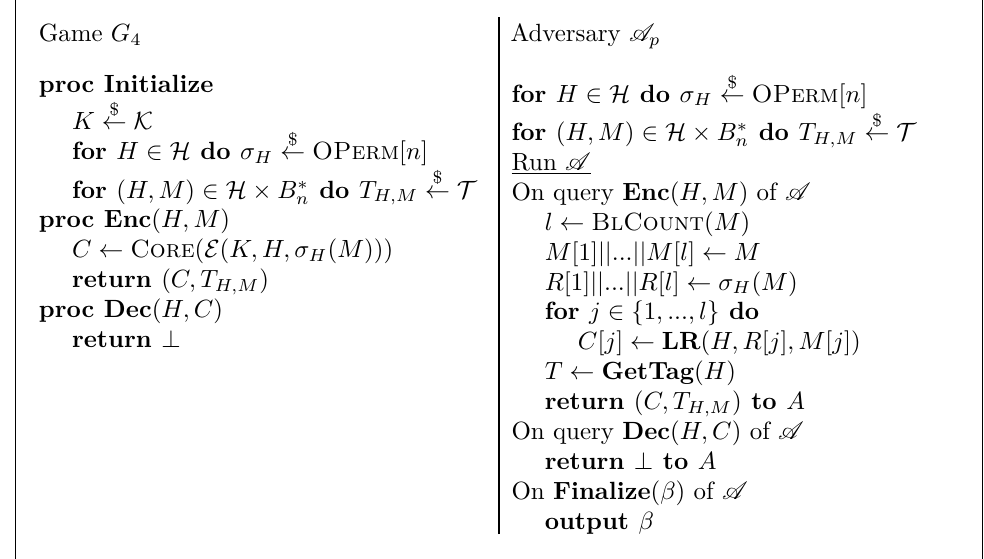
Figure 14: Game G 4 (left) and adversary A p (right) for the proof of Lemma